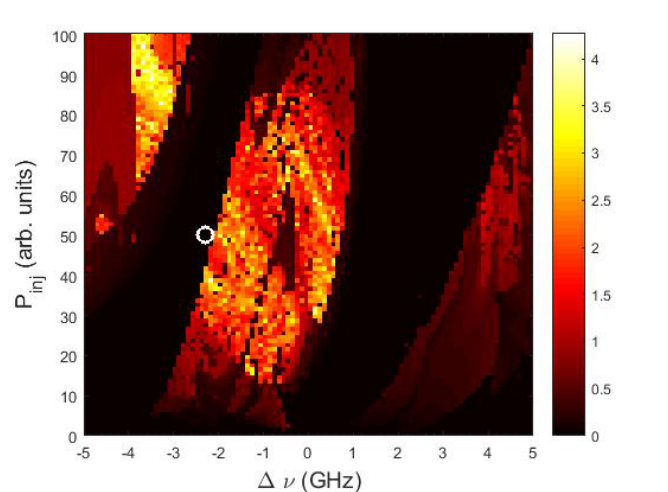
Figure 1. Relative height of the intensity oscillations when no perturbation is applied ( ∆ P = 0), as a function of the frequency detuning, ∆ ν , and the injection strength, P inj . The color code displays ∆ I = ( I max − (cid:104) I max (cid:105) ) / (cid:104) I max (cid:105) , with I max and (cid:104) I max (cid:105) being the maximum and the average height of the intensity oscillations, respectively; the symbol indicates the parameters used in Figure 2: P inj = P 0 = 50 ns − 2 and ∆ ν = − 2.29